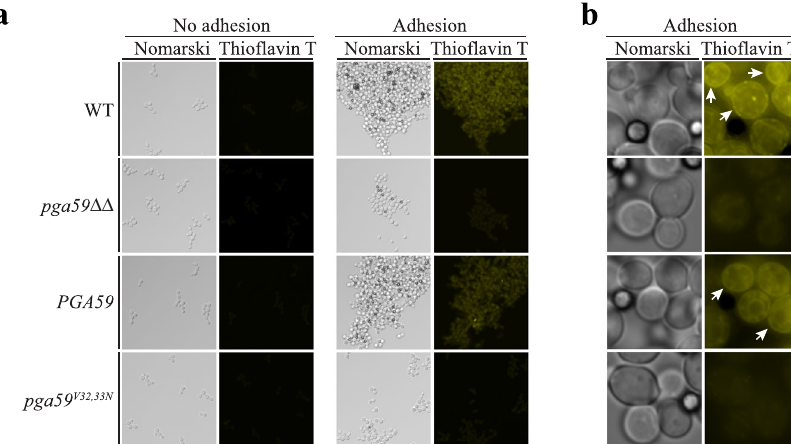
Fig. 4 C. albicans assembly of amyloid structures upon adhesion requires Pga59. a Amyloid structures formation in C. albicans was monitored by using ThT staining. WT, pga59 Δ /pga59 Δ , PGA59/pga59 Δ and pga59 V32,33N /pga59 Δ strains were cultured in a YPD medium. Adhesion was triggered by adding magnetic beads to the culture medium. Fungal cells without magnetic beads were used as a negative control (no adhesion, left panels). The ThT signal was recorded in the yellow channel while cells were observed by Nomarski (with a 20X objective). Scale bar: 25 μ m. b Amyloid assembly was monitored with ThT staining (yellow channel) at higher magni fi cation (with a 100X objective). Amyloid structures found in the cell wall are indicated with white arrows. Scale bar: 3 μ m.